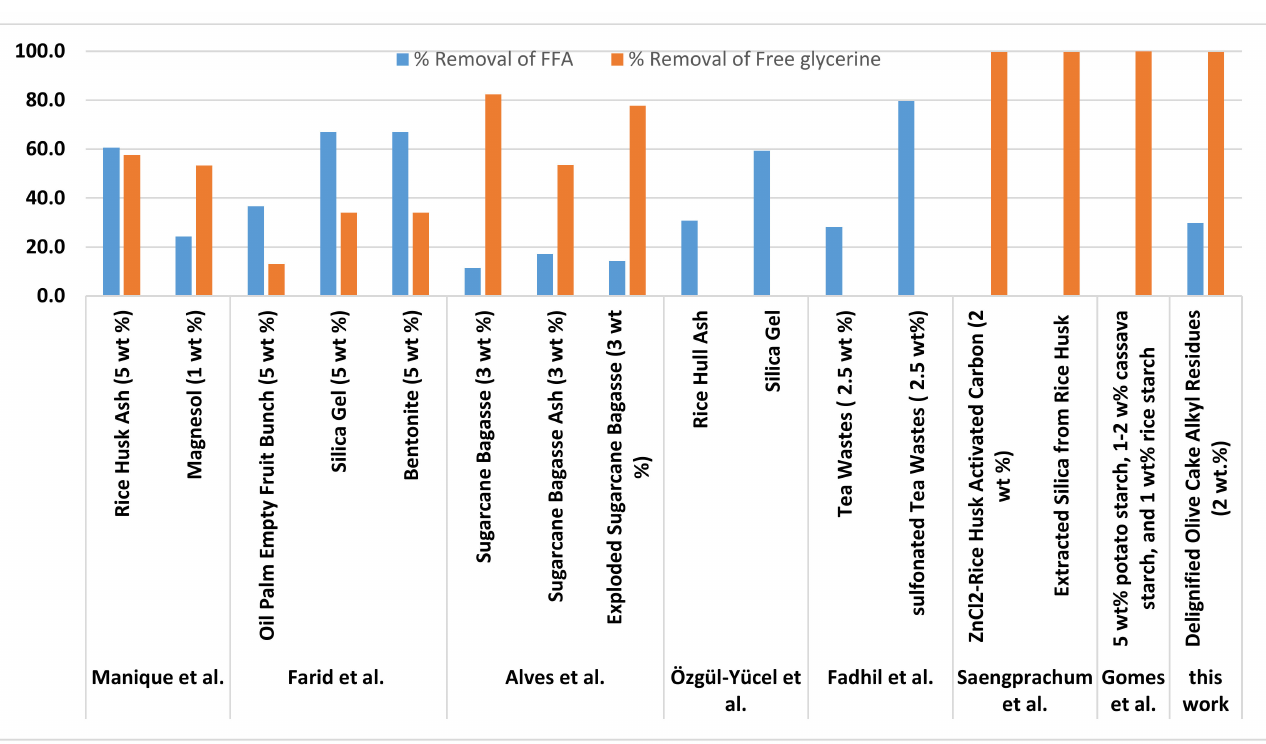
Figure 3. Comparison between the % removal of FFA and free glycerin obtained in this study using olive cake alkyl residues (particle sizes of 150 µ m) and other commercial adsorbents and biomass-based adsorbents.